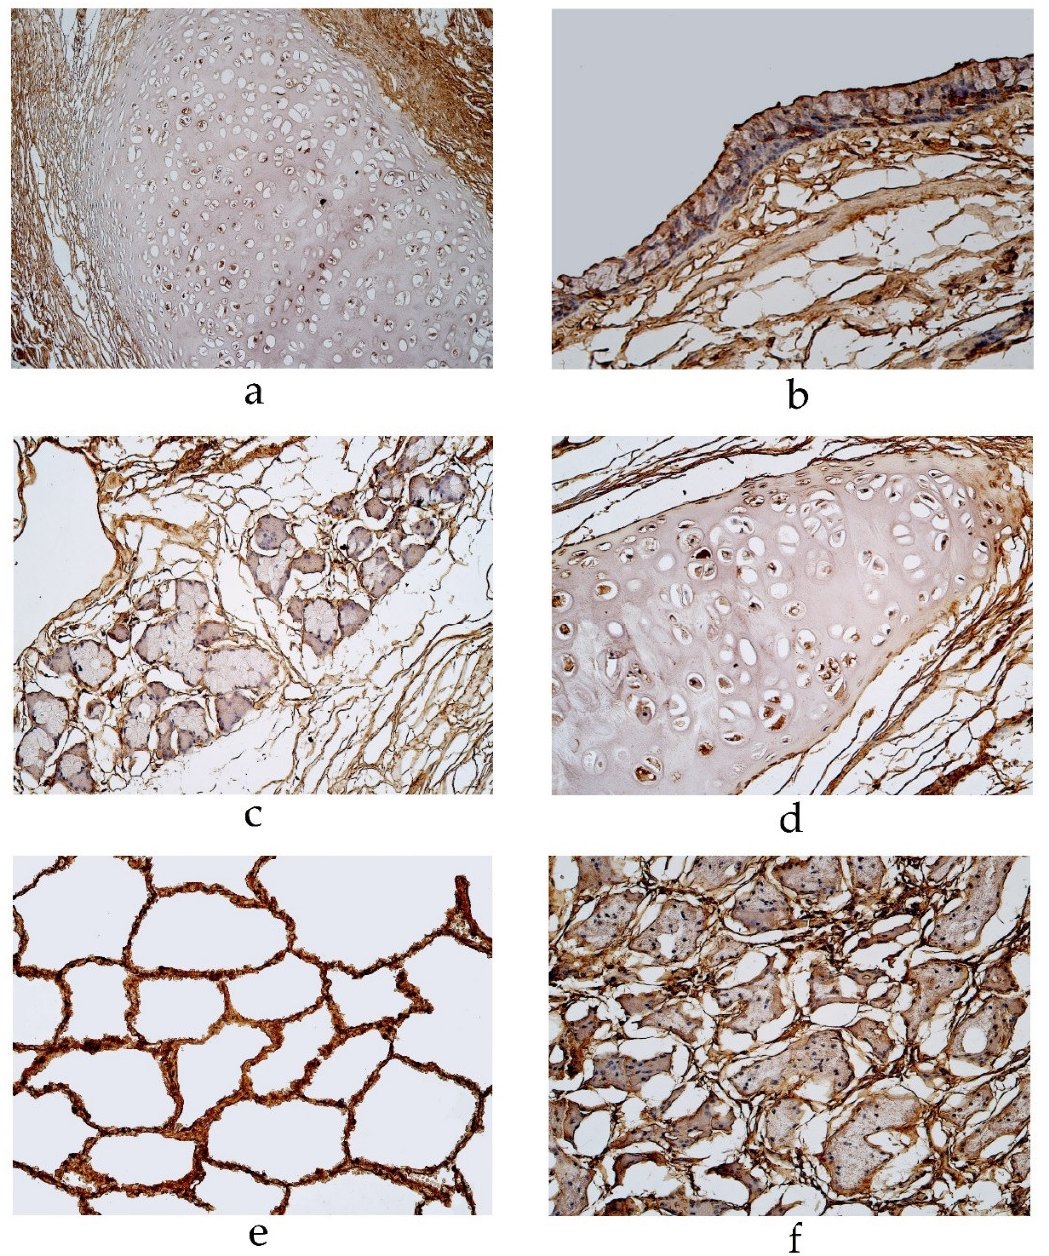
Figure 5. Immunohistochemical micrographs of the lungs ( a ) A moderate number of IL-13 positive cells observed in cartilage of a 19-year-old male in the pseudostratified ciliated epithelium group. IL-13 IMH, X200; ( b ) A few IL-13 positive structures in the bronchial epithelium of a 29-year-old male in the pseudostratified ciliated epithelium group. IL-13 IMH, X200; ( c ) A few IL-13-staind cells in the glands of a 95-year-old female in the pseudostratified ciliated epithelium group. IL-13 IMH, X200; ( d ) A moderate IL-13-stained cells in the cartilage of a 23-year-old male in the stratified squa- mous epithelium group. IL-13 IMH, X200; ( e ) A moderate number of IL-13-stained alveolar epithe- lium cells in an 86-year-old male of the stratified squamous epithelium group. IL-13 IMH, X200; ( f ) A few to a moderate number of IL-13 positive weakly stained cells observed in the glands of an 86- year-old male in the stratified squamous epithelium group. IL-13 IMH, X200.